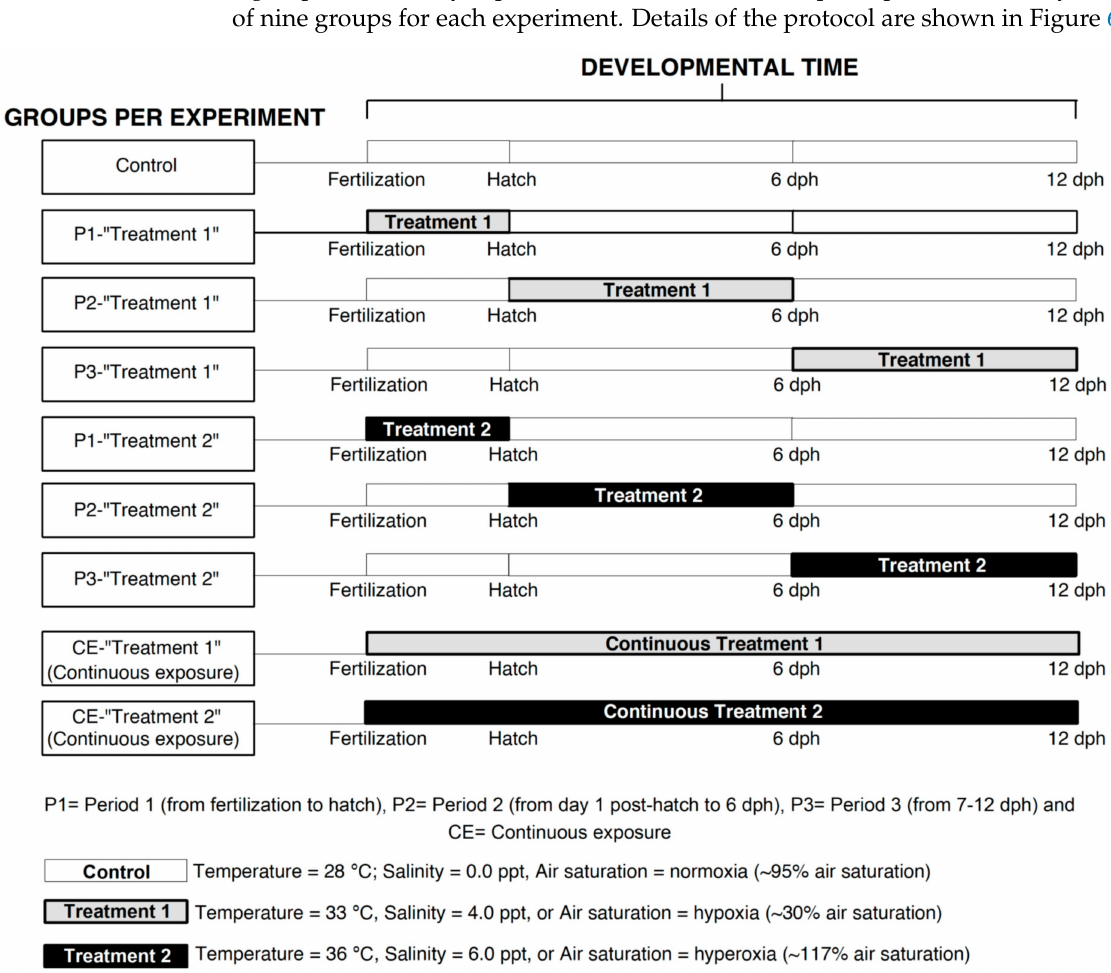
Figure 6. Experimental design for determining specific environmental effects on critical windows for development in the early ontogeny of Atractosteus tropicus . The first developmental period is from fertilization to hatching (~72 h), the second from 1 day post hatch (dph) to 6 dph, and the third from 7 to 12 dph. White boxes indicate control conditions during the experiments; light gray boxes represent exposure to treatments 1 (33 ◦ C, hypoxia (~30% air saturation) or salinity of 4.0 ppt); darker boxes show exposure to treatments 2 (36 ◦ C, hyperoxia (117% air saturation) or salinity of 6.0 ppt). Boxes at the bottom explain the conditions for control populations and treatments 1/treatments 2 during each independent experiment. See text for